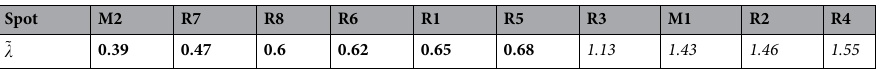
˜ (cid:31) = (cid:31) 2 Table 1. Values of the ratio of decay parameters (cid:31) 1 as obtained from application of our decay model [see Eqs. (1) and (5)] to the field data of Klein et al. 11 . Values are given in increasing order of ˜ (cid:31) ≥ 1 shown in bold, values are shown in italic. Spot location are denoted as in Klein et al. 11 : M1 and M2 are sites at the Main river which flows into the Rhine river between R1 and R2. R1-R8 are sites at the Rhine river. For both rivers larger numbers indicate a further downstream location.